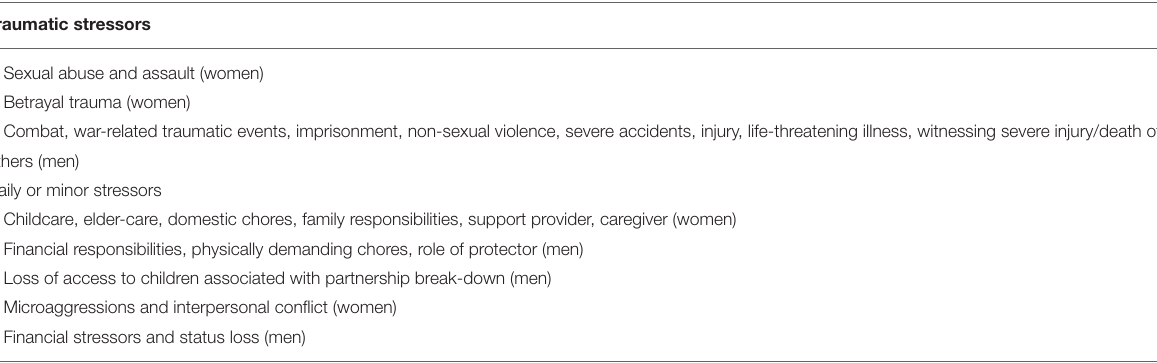
TABLE 6 | Examples of stressors relevant to sex